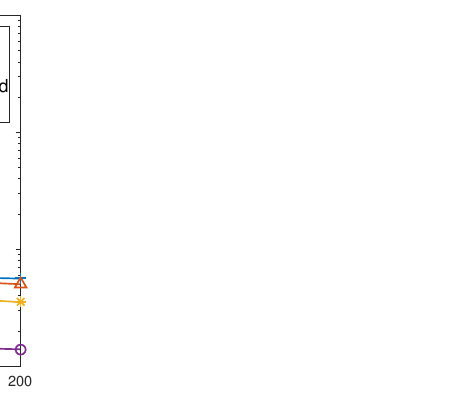
Figure 9. Gain-phase error estimation RMSE performance versus the number of snapshots, SNR = 20 dB.